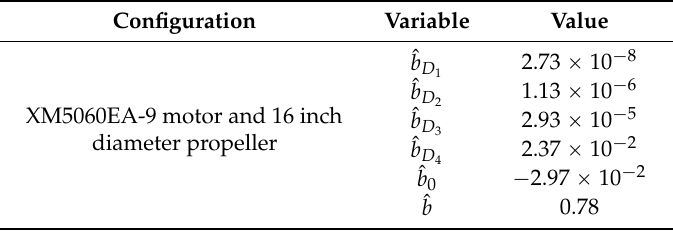
Table 1. The estimates of the coefficients of the electric variable-pitch